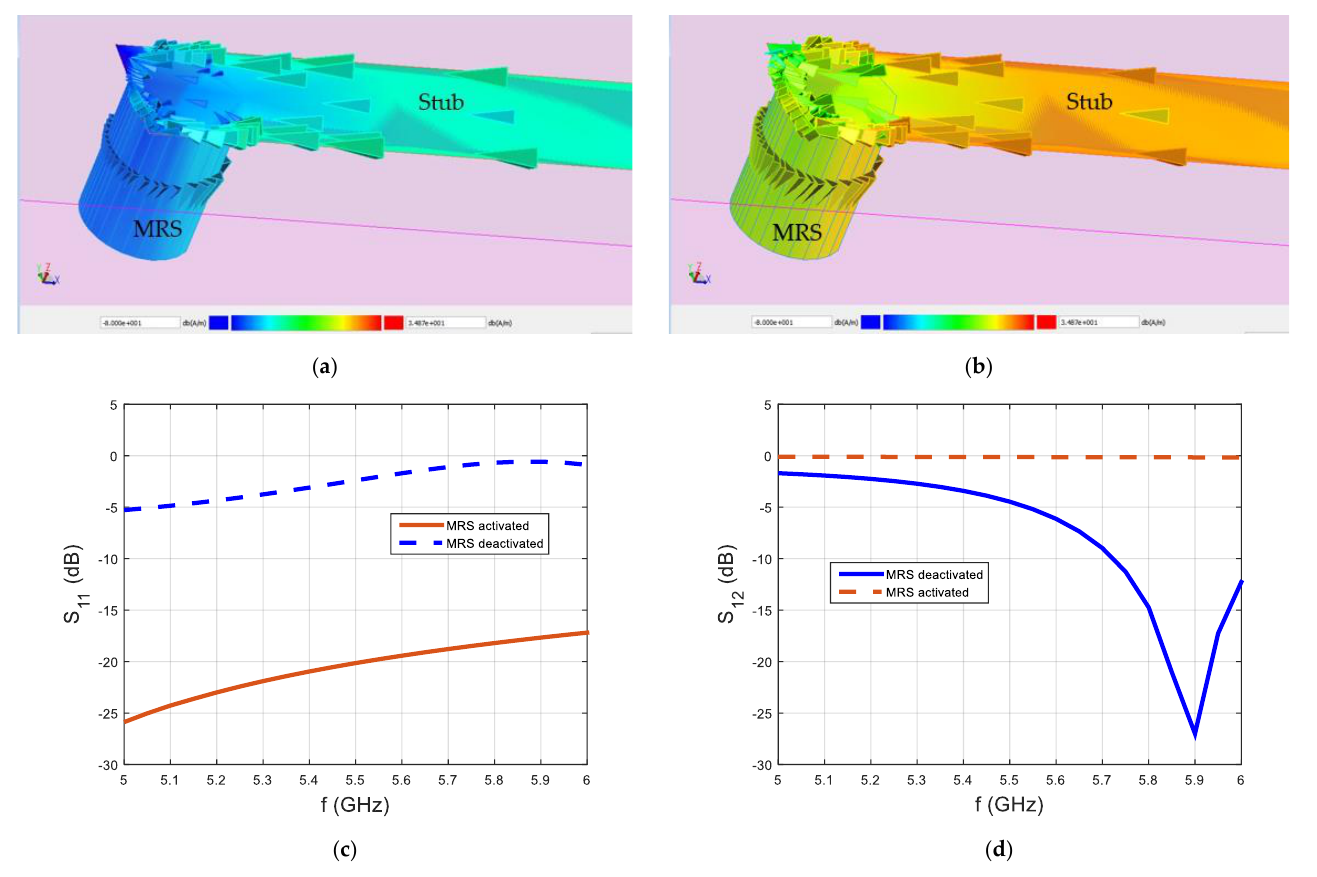
Figure 3. Illustration of connection/disconnection of a stub with the ground plane using magnetic